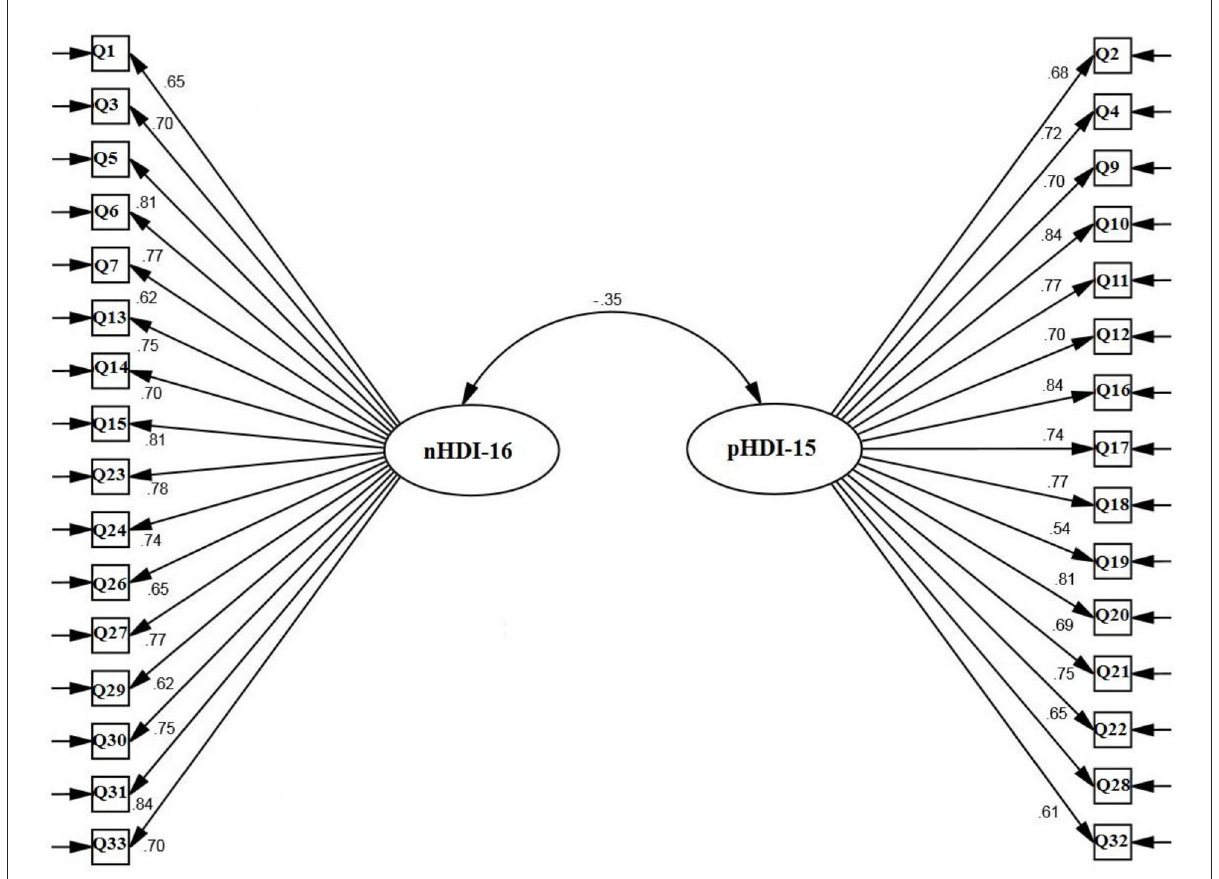
FIGURE1 Confirmatory factor analysis of food frequency consumption